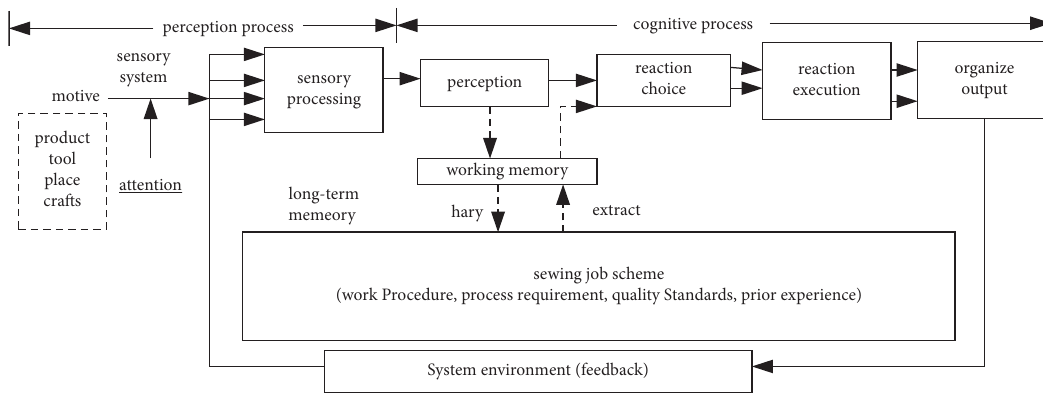
Figure 3: Model of sewing operation information